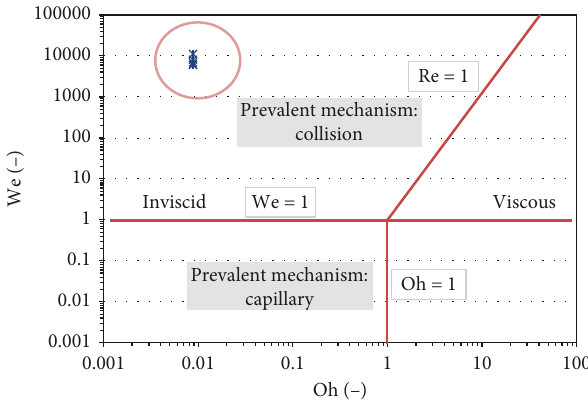
Figure 7: Impact regime diagram [27] of experiments